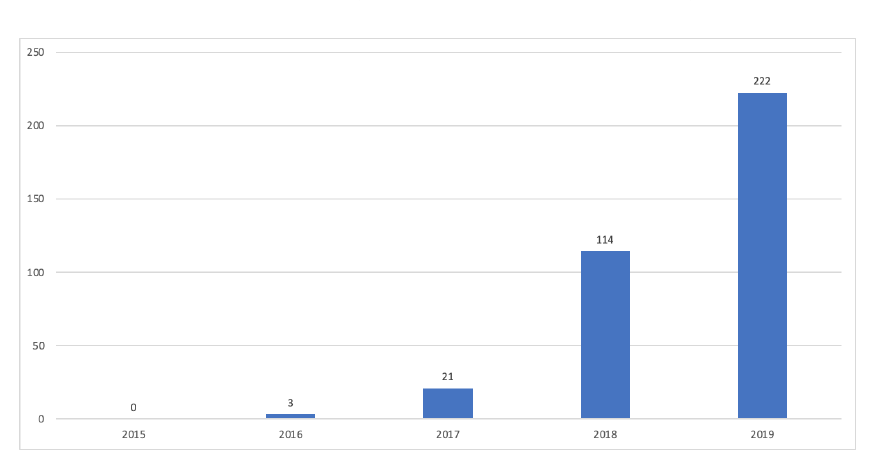
Figure 3. Number of publications on blockchain and the transport sector over the years.